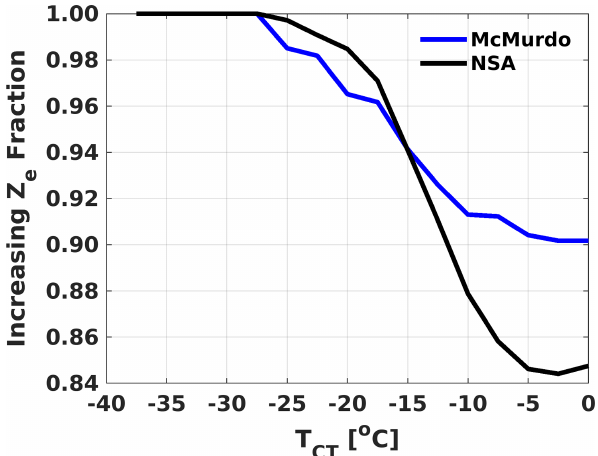
Figure D1. Fraction of detected precipitating supercooled clouds over McMurdo Station and the NSA in which Z e increases between 60 and 150m below cloud base, as a function of upper T CT limit, i.e., including all precipitating supercooled clouds with T CT up to the x axis values (bin widths of 2.5 ◦ C). See Appendix D for dis-